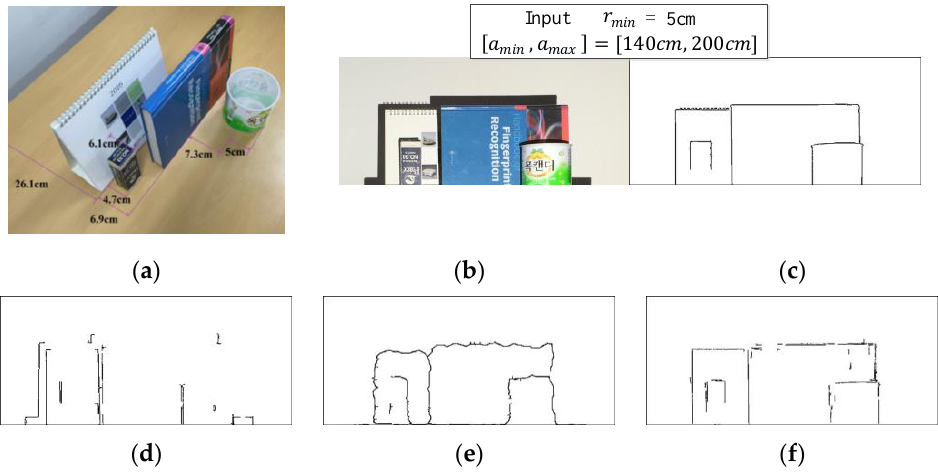
Figure 12. Depth edge filtering results for 𝑟 ≥ 5 cm : ( a ) experimental setup; ( b ) front view; ( c ) ground truth; ( d ) method in [8]; ( e ) Kinect; ( f ) our method.